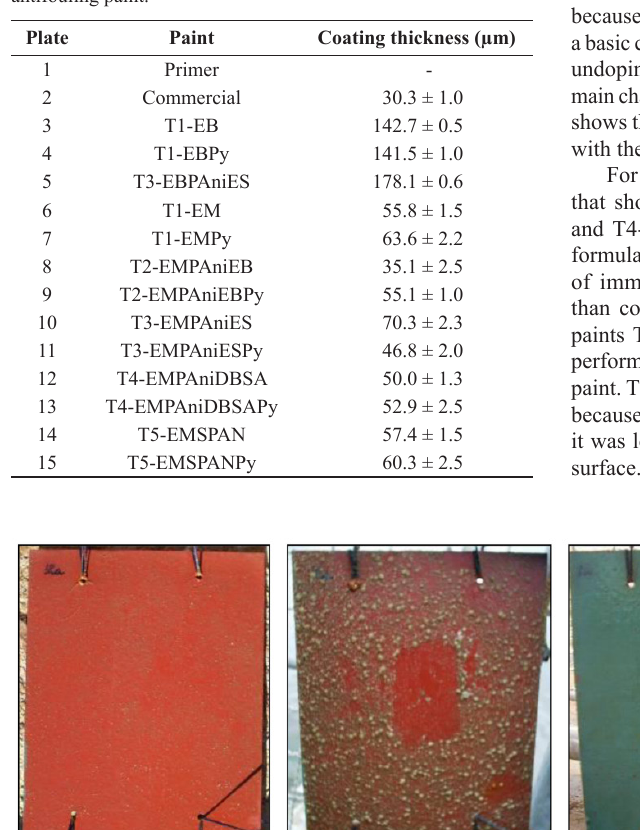
Table 5. Paints used in steel plates and dry film thickness of antifouling paint.